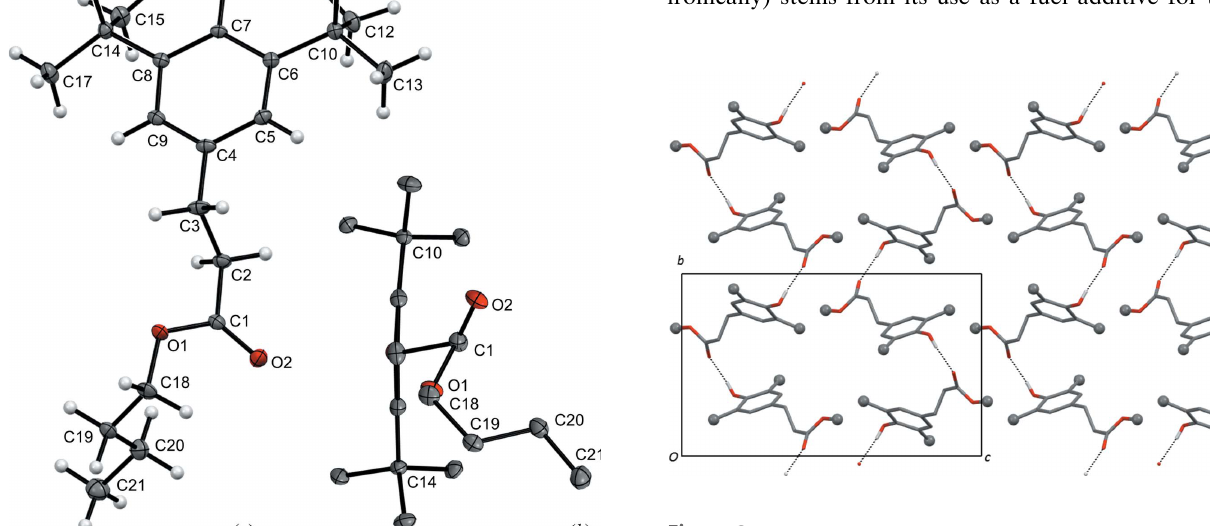
Figure 3 The unit cell and crystal packing viewed along the a axis. For clarity, only the hydroxylic H atoms have been included, while methyl and butyl groups are shown as small spheres. Hydrogen-bonded chains run along the vertical b axis.